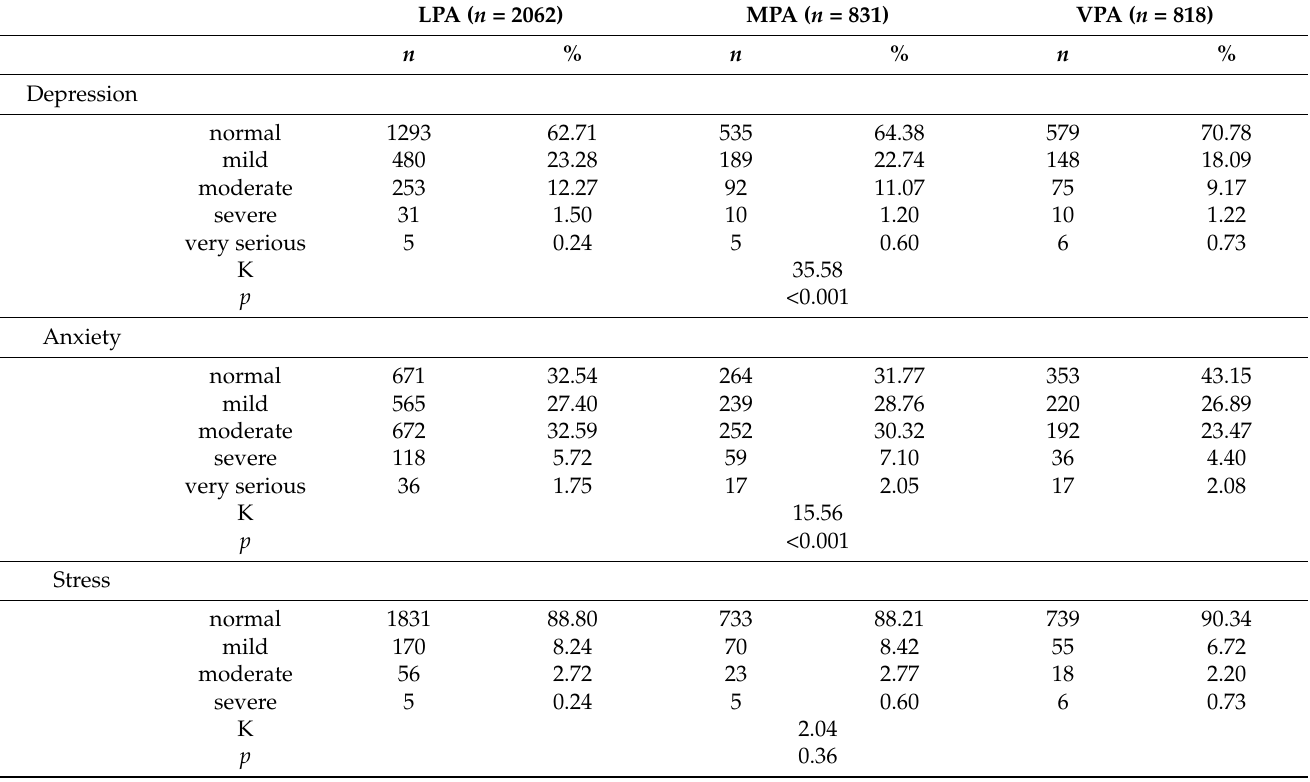
Table 3. NM rates in different PA groups ( n = 3711).